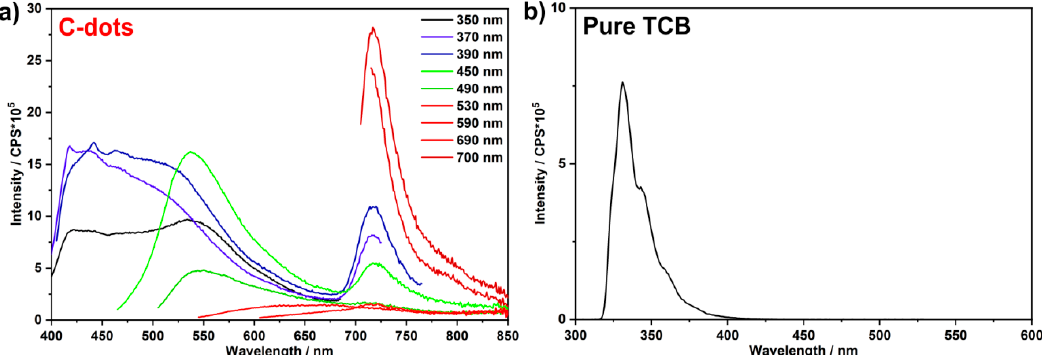
Figure 6. Emission of as-prepared C-dots: ( a ) emission spectra (suspension in PEG400) at different wavelengths of excitation; ( b ) emission spectrum of pure TCB (solution in chloroform, excited at λ exc = 272 nm).